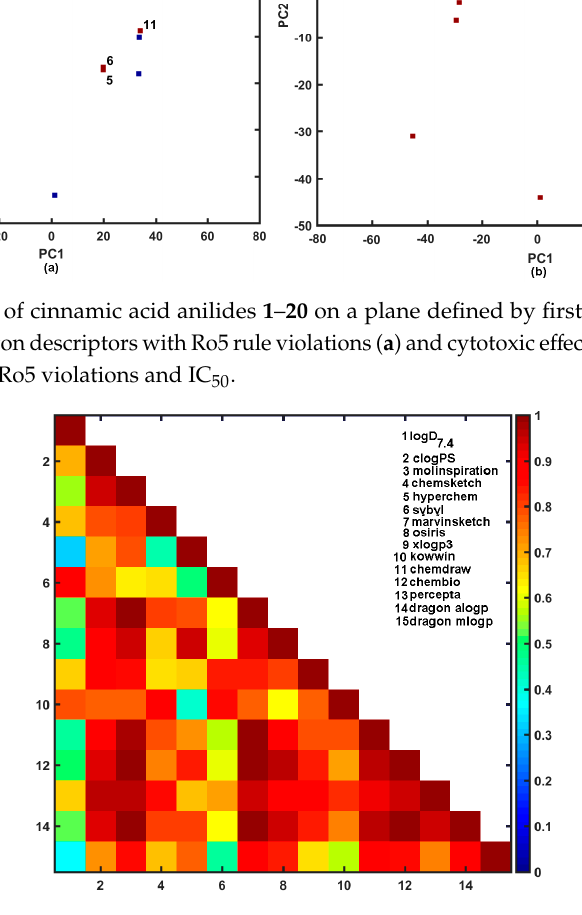
Figure 4. Matrix of correlation coefficients of linear relationships between experimental and calculated logD 7.4 lipophilicity specified using different programs.